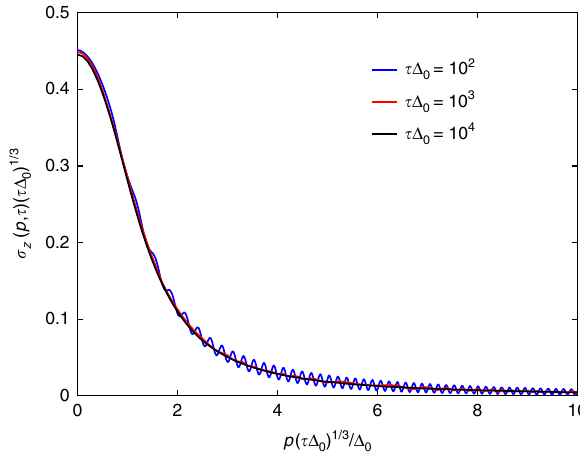
Fig. 2 Momentum resolved defect density for the PT-symmetric ramp. The scaling and data collapse of the numerically determined momentum resolved defect density, f PT ( x ) in the near-adiabatic limit is shown for several values of τ for the PT-symmetric